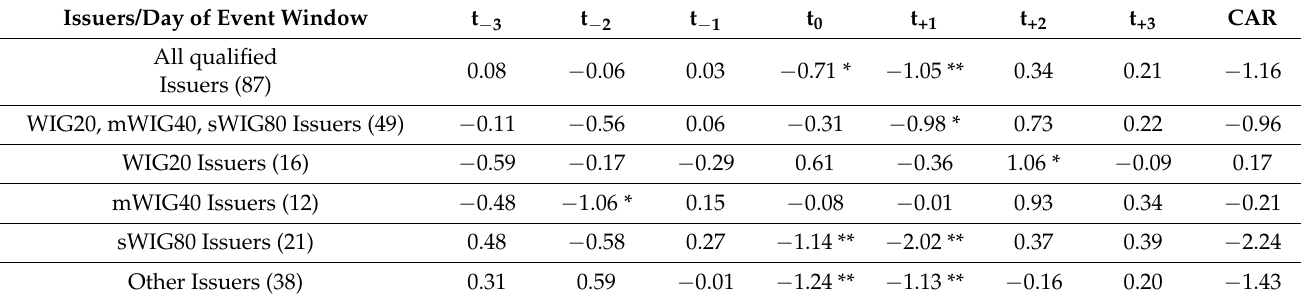
Table 4. Cross-section analysis of AAR for each qualified case of reporting IoA by issuers from the WIG index in years 2013–2018 (in percentage